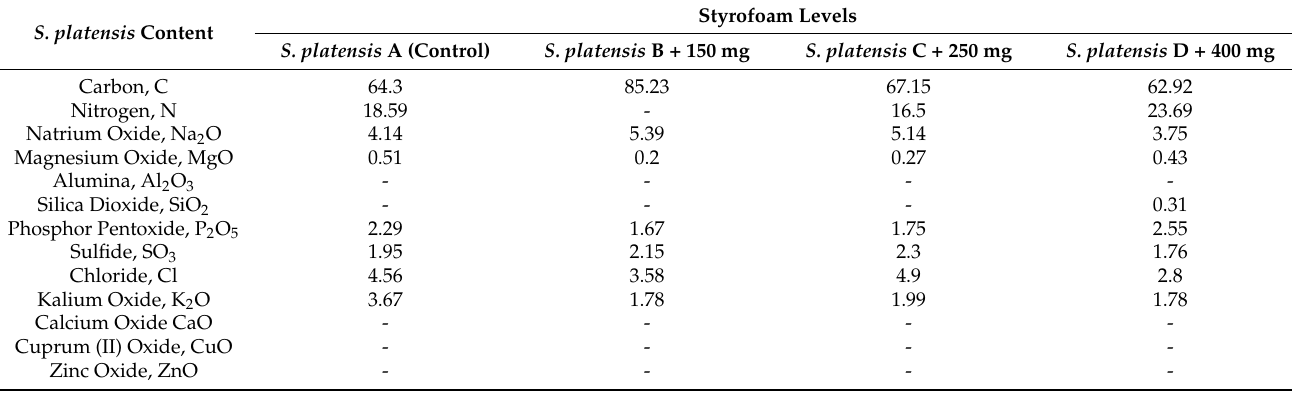
Table 4. Energy Dispersive X-ray spectroscopy (EDX) analysis results for the chemical constituents of S. platensis cultured in brackish water for 30 days.